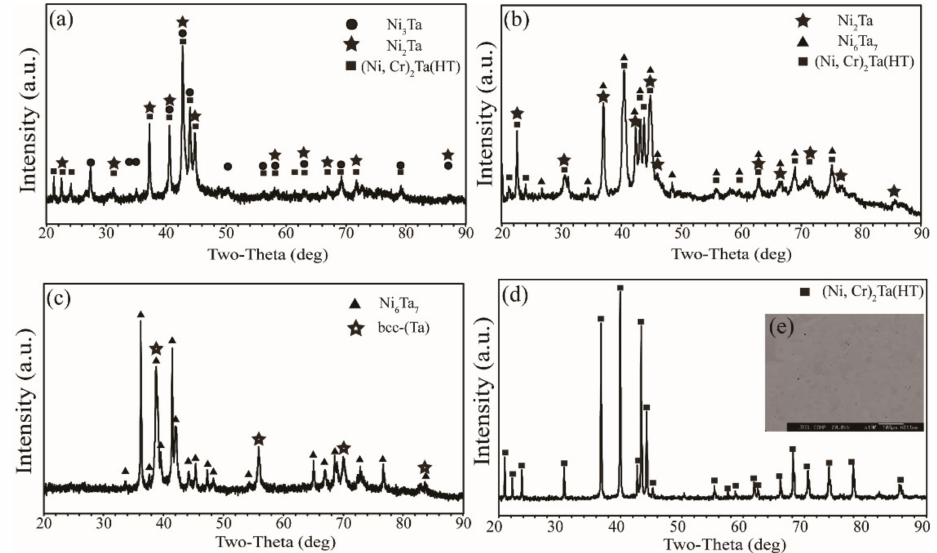
Figure 3. The XRD patterns of typical alloys in the Ni-Cr-Ta system annealed at 1200 ◦ C for 35 days. ( a ) Ni 64 Cr 7 Ta 29 ; ( b ) Ni 53 Cr 8 Ta 39 ; ( c ) Ni 12 Cr 33 Ta 55 ; ( d ) Ni 13 Cr 53 Ta 34